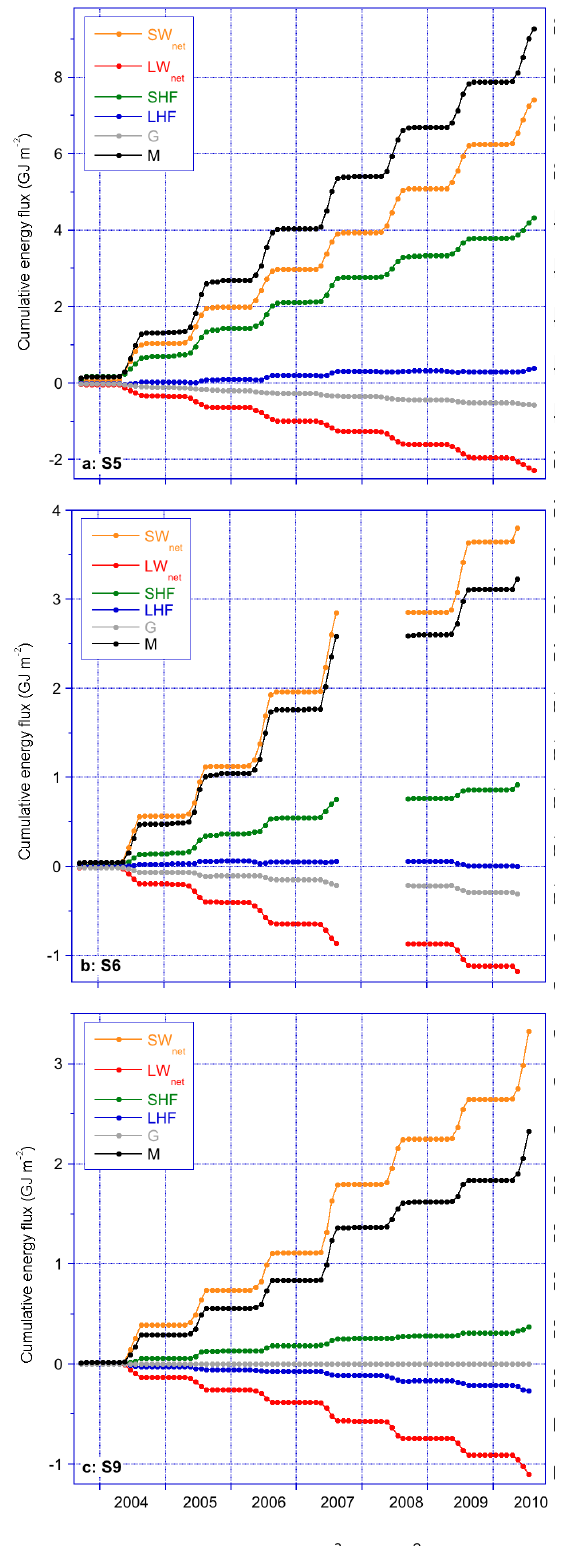
Fig. 9. Cumulative energy fluxes (10 3 MJm − 2 ) during melt for S5 (a) , S6 (b) and S9 (c) .